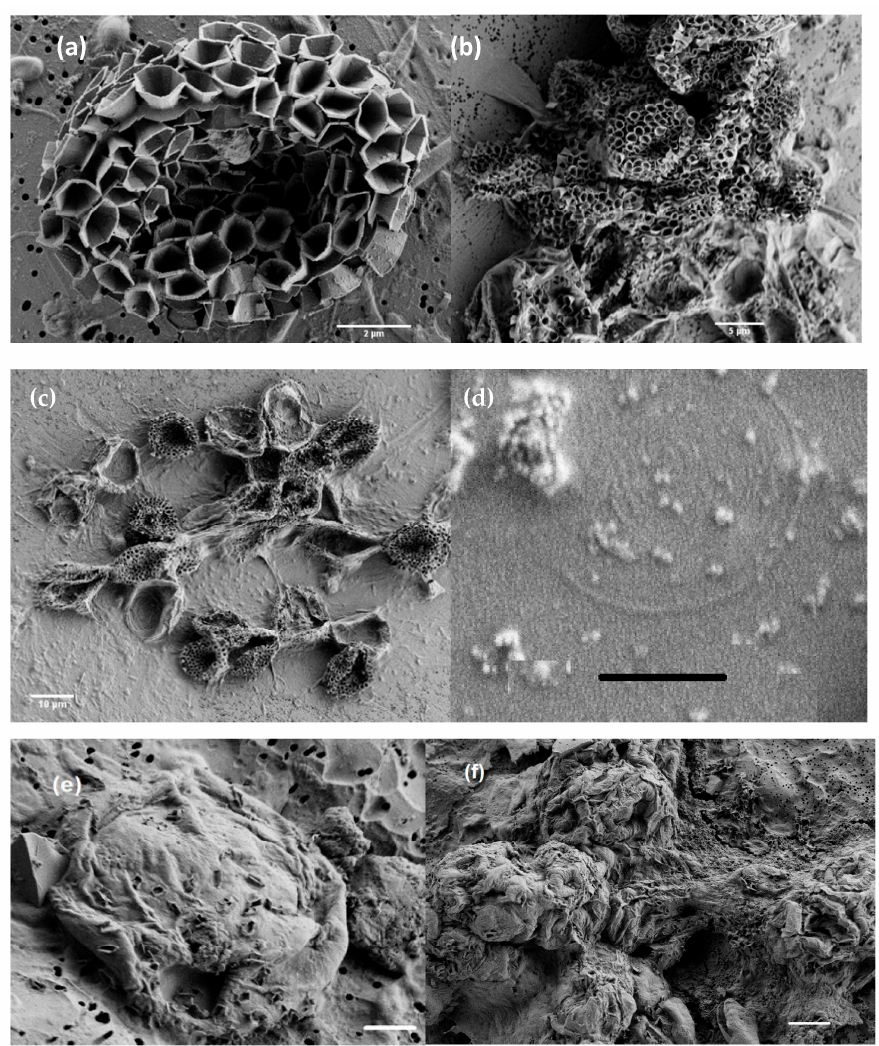
Figure 2. Ochrosphaera neapolitana images from the SEM: ( a ) a coccolith-bearing diploid cell scale bar; scale is 2 µ m, ( b ) a group of coccolith-bearing cells; scale is 5 µ m, ( c ) an aged colony, scale 10 µ m, ( d ) an organic base-plate scale of an S-cell; scale is 300 nm, ( e ) a coccolith-bearing cell fixed with 1% osmium tetraoxide; scale 1 µ m, and ( f ) deformed cells after fixing with osmium tetraoxide; scale 4 µ